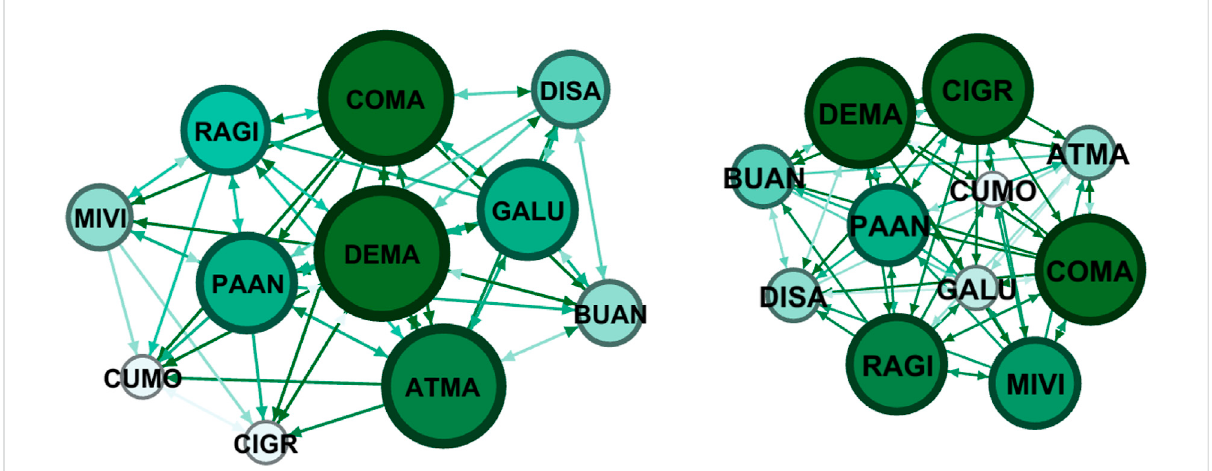
FIGURE 3 Pre-Test (on the left) and post-test (on the right) Sociograms on affective/relational dimension for the control group.